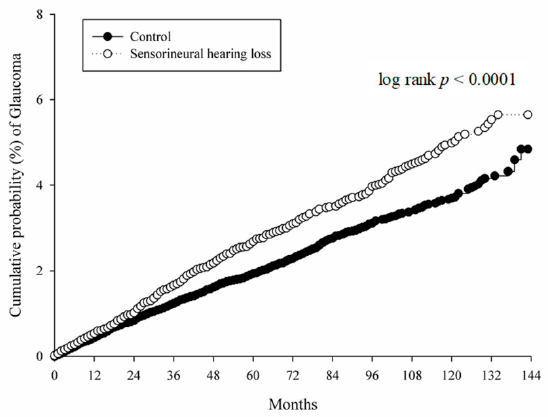
Figure 2. Kaplan-Meier curves with cumulative proportion of subconjunctival hemorrhage in the propensity score matched study and control groups.